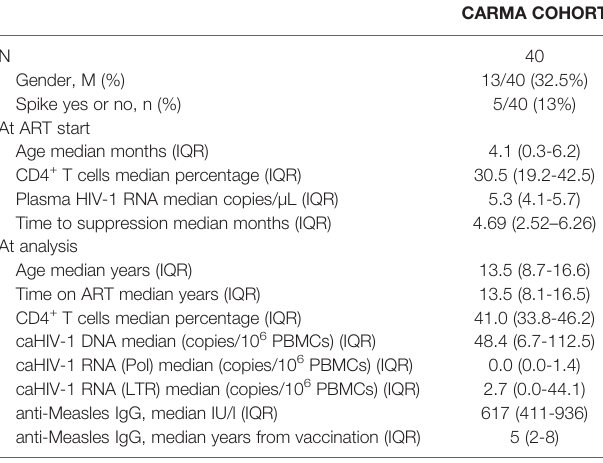
TABLE 1 | Characteristics of the study population.